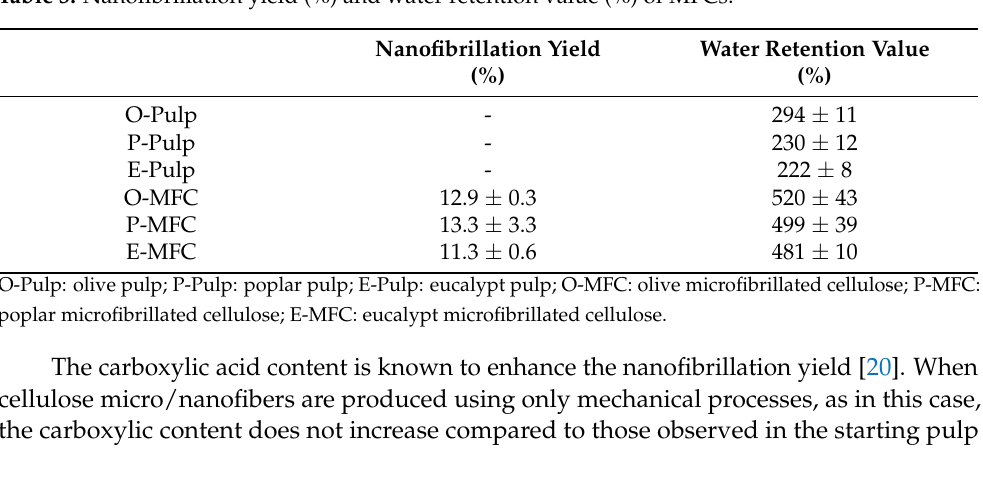
Table 3. Nanofibrillation yield (%) and water retention value (%) of